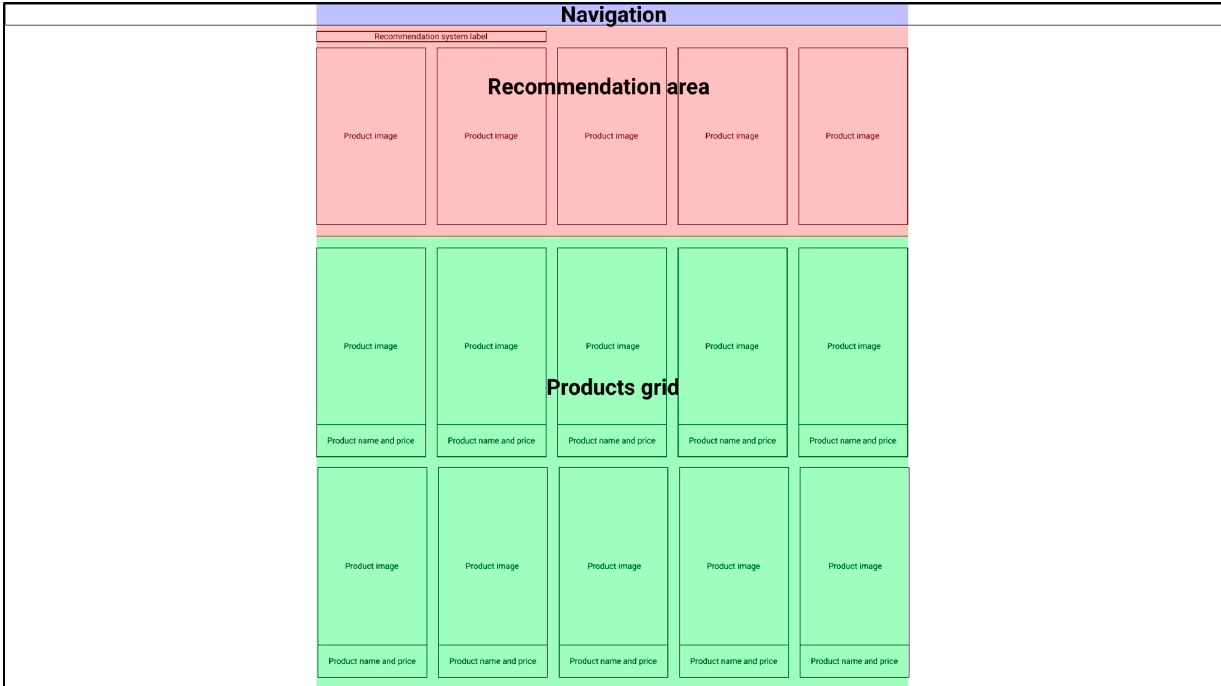
Figure 2. Experimental design of the online store webpage. Main subareas of the webpage highlighted in colors: Navigation (purple bar at the top), recommendation area (first below the top navigation bar), product grid (bottom green area), and background (left and right white space).